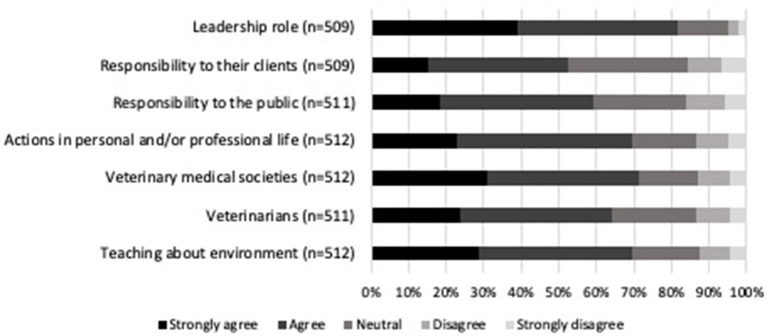
Percentage of level of agreement or disagreement from veterinarians on the potential involvement of the veterinary profession on climate change and health. Complete statements can be found in Appendix 1.